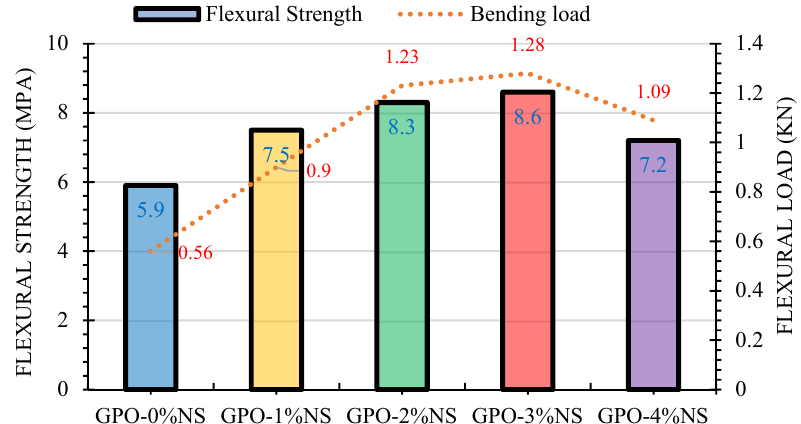
Figure 8. Effect of different quantities of NS on the FLS and bending loads of mixes.